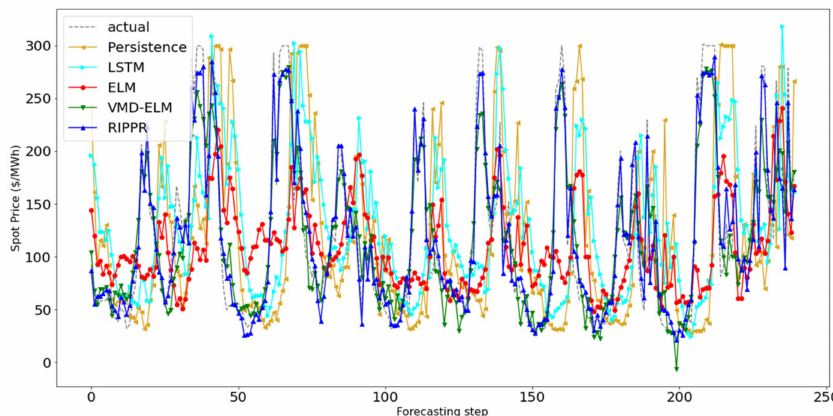
Figure 6. Six steps ahead forecasting for dataset A.